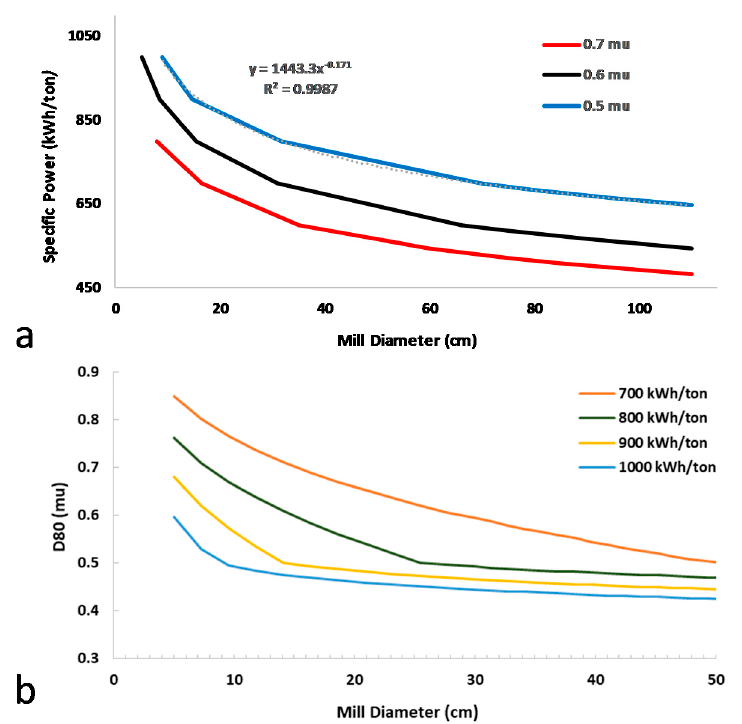
Figure 13. ( a ) Theoretical dependence of the specific power on the diameter dimension of the ball mill, and ( b ) correlation between the d80 and the mill diameter for different specific power inputs.